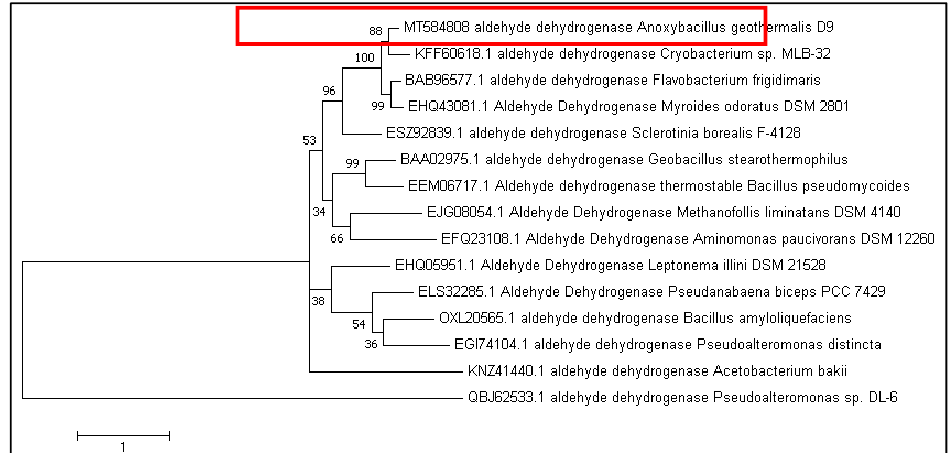
Figure 1. Phylogenetic tree of A. geothermalis ALDH from the Anoxybacillus geothermalis D9 (red box) and the related sequences of aldehyde dehydrogenases generated using MEGA 10.0. The amino acid sequences were retrieved from the National Center of Biotechnology (NCBI).